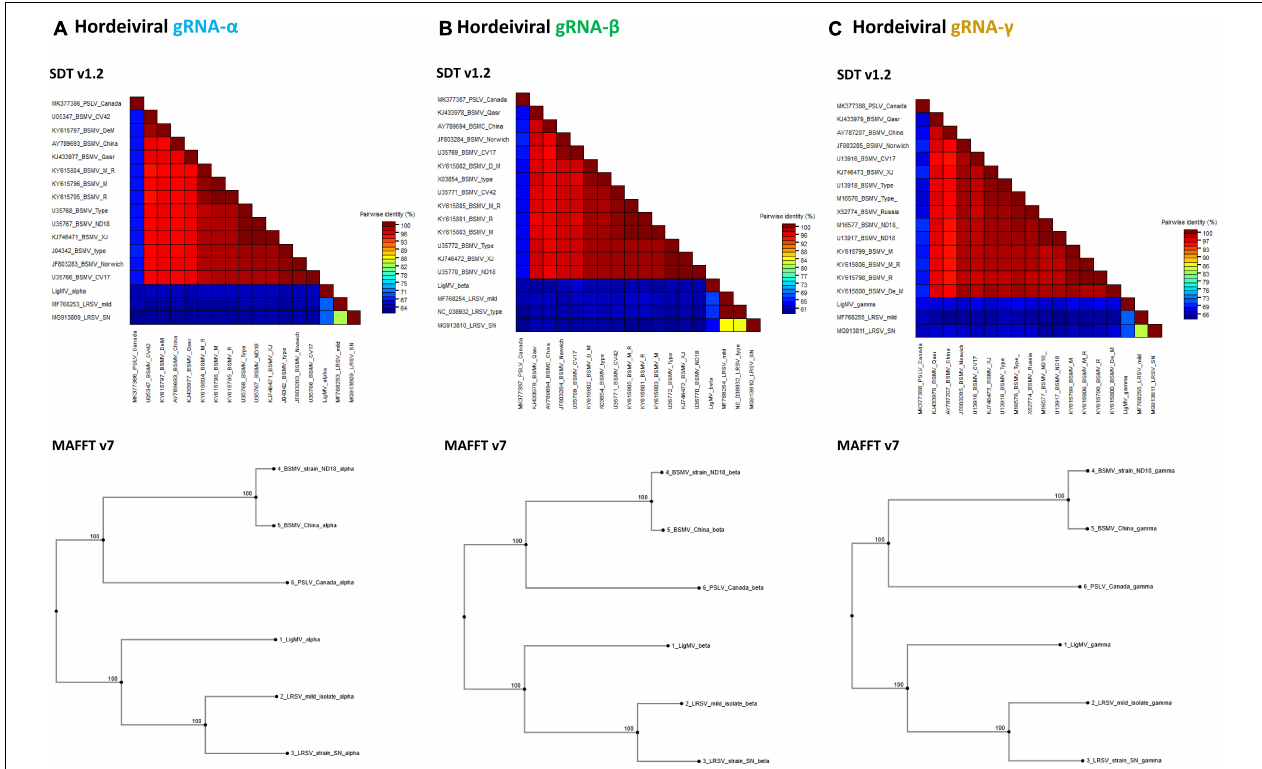
FIGURE 4 | Phylogenetic analysis of ligustrum mosaic virus (LigMV). Percentage of pairwise nucleotide identity (excluding indels) between complete sequences of hordeiviral gRNAs α (A) , β (B) , and γ (C) , was calculated using Sequence Demarcation Tool (SDT v1.2; Muhire et al., 2014) with MUSCLE option and shown